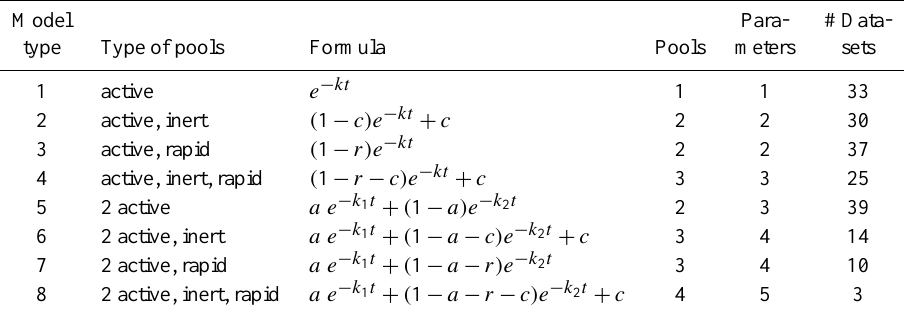
Table 1. This table shows the wide and seemingly unpredictable variation in the types of pool models that best fit 191 LIDET datasets. Each model was obtained by solving the non-negative least squares problem (5) and analyzing the resulting ρ to determine whether the pools were active (decaying exponentially), inert, or rapid, as discussed in the text. The first column lists the model type, the second column indicates kinds of pools present in that model, the third column provides the formula for the model, the fourth column gives the total number of pools in the model, the fifth column indicates the total number of parameters in the model, and the sixth column indicates how many LIDET datasets are best fit by that model. The sizes of the constant, rapid, and active pools in the models are c , r , and a , respectively. The size of one of the pools is determined by the others since mass fractions must sum to one. Model